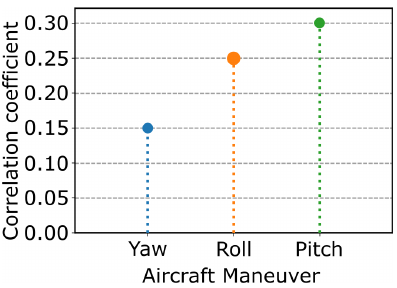
Figure 16. Correlation coefficient of the RMI and aircraft maneu-